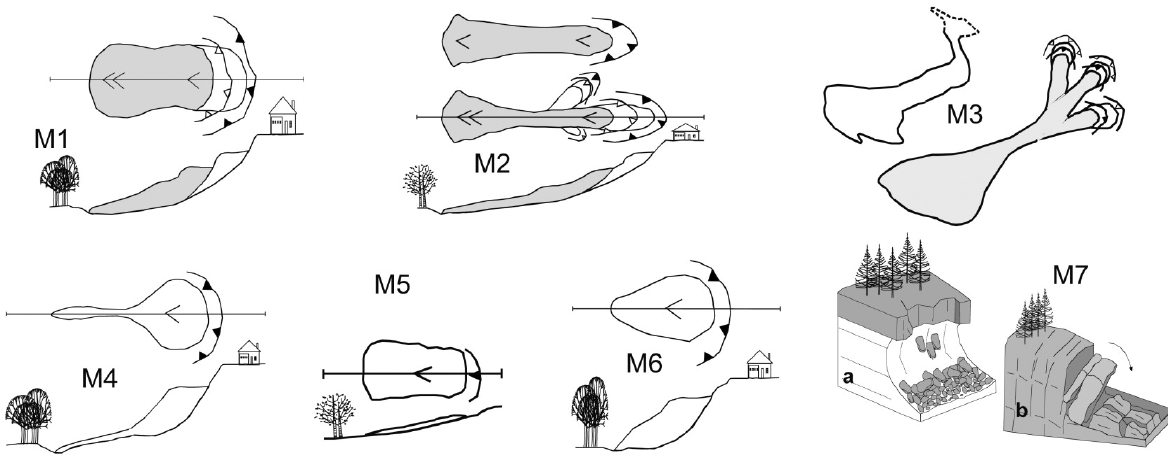
Figure 5. Recurrent landslide mechanisms (Mi) in Daunia Apennines (after [44]).